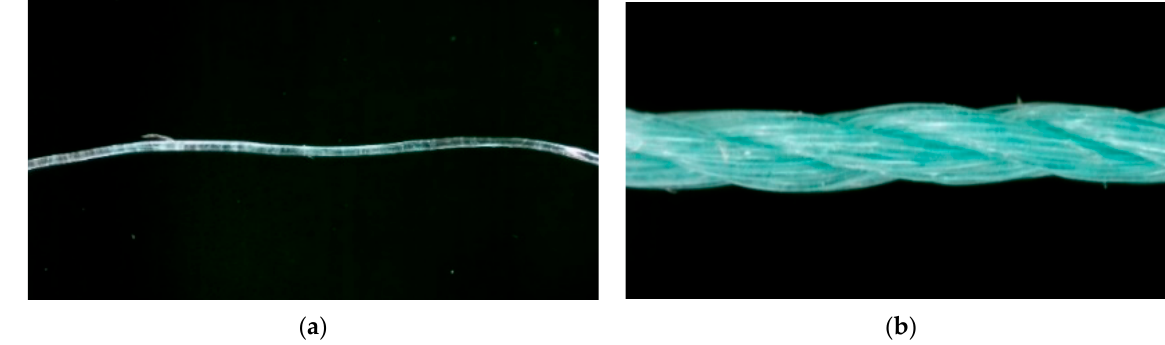
Figure 1. Geometry of the waste fishing net (WFN) fibers: ( a ) Filament; ( b ) fiber.